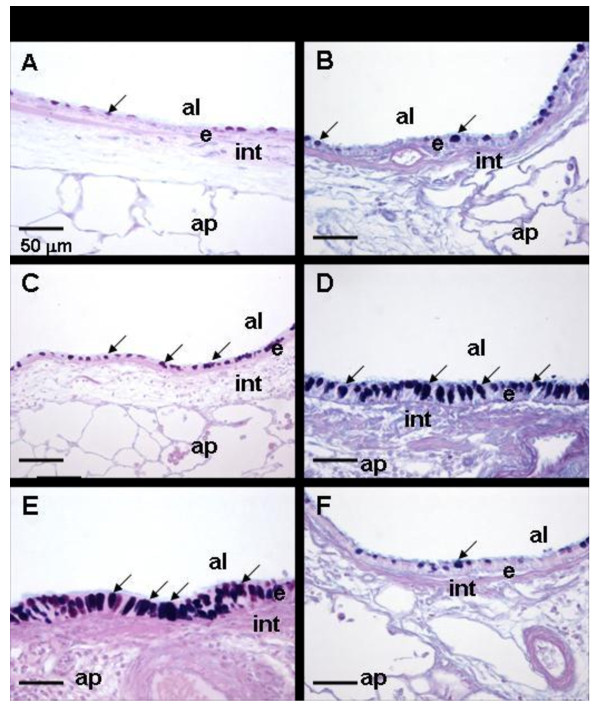
Effect of CAPs exposure on mucous cell metaplasia in allergic pulmonary airways. Photomicrographs of the respiratory airway epithelium lining the axial airway in lungs of rats sensitized and challenged with saline (A, B), or with Ovalbumin (C-F). Rats were exposed to filtered Air (A-D) or to CAPs in Detroit (E) or Grand Rapids (F). Tissues were stained with AB/PAS to identify intraepithelial mucosubstances (identified by arrows). al = airway lumen; ap = alveolar parenchyma; e = epithelium; int = interstitium; arrows = intraepithelial mucosubstances. Magnification bar = 50 μm.